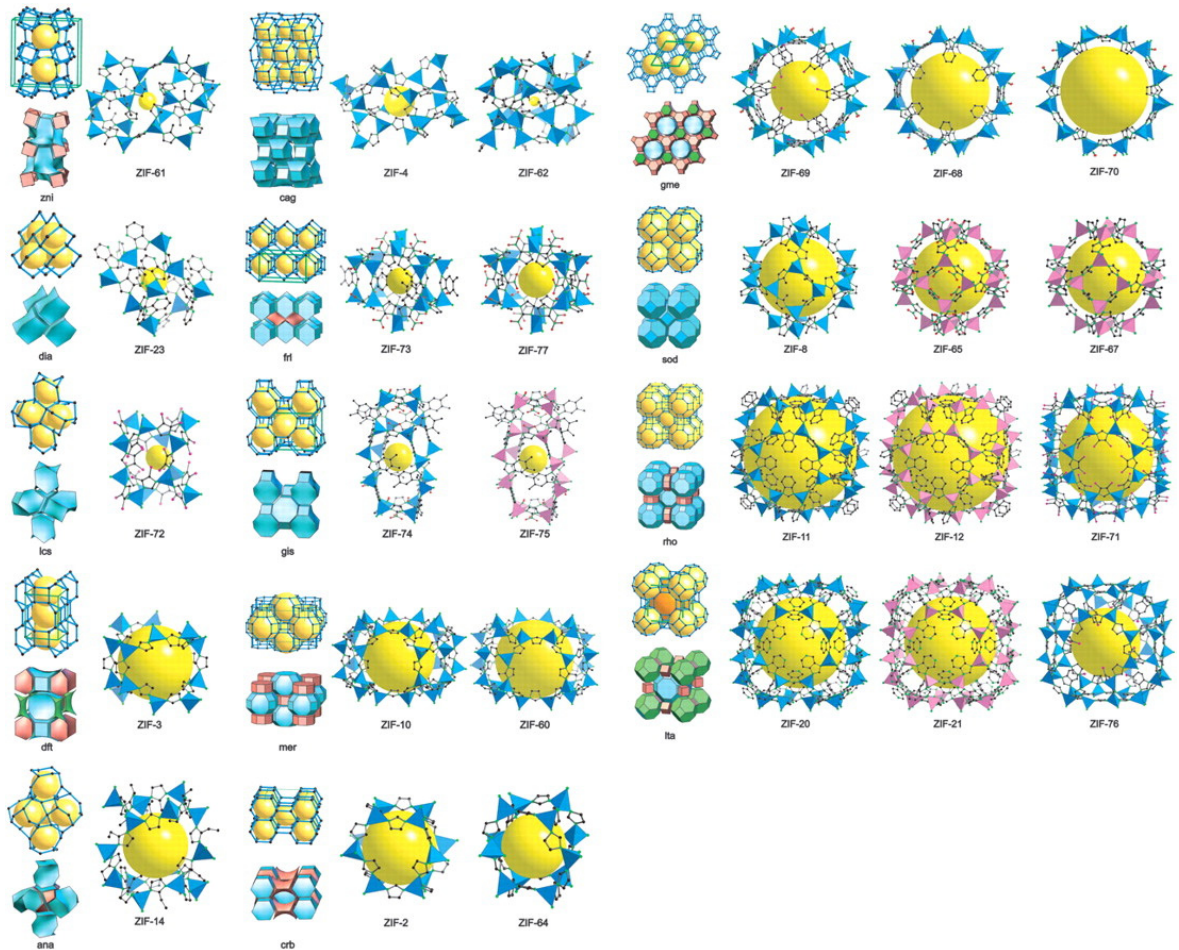
Figure 6. The crystals of ZIFs. The largest cage in each ZIF is shown with the ZnN 4 tetrahedra in blue and the CoN 4 in pink. The yellow ball is included in the structure for clarity and to indicate space in the cage. Reprinted with permission from [101], copyright 2008 American Association for the Advancement of Science.